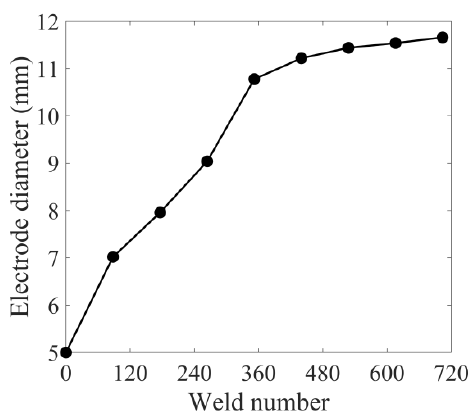
Figure 13. Changes in the electrode diameter during its failure process.